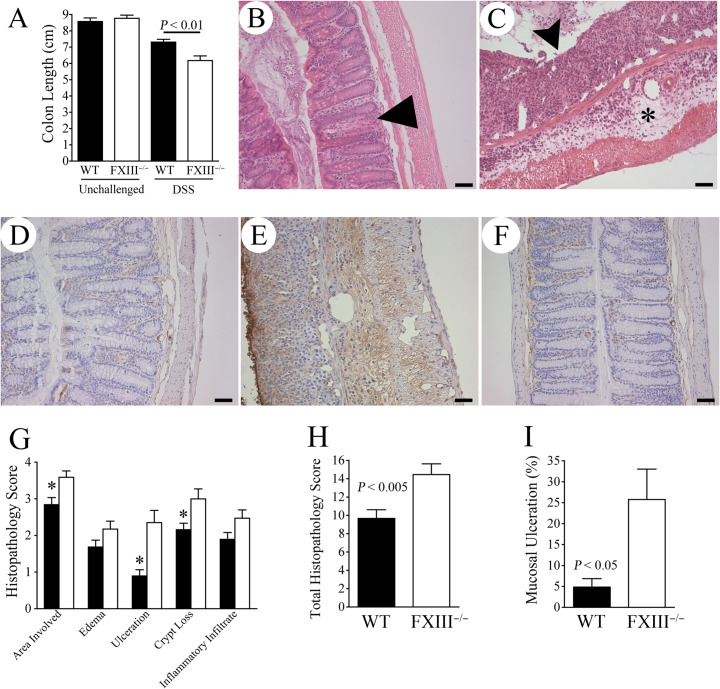
Lack of FXIII results in a failure to resolve colonic damage after DSS exposure.(A) Colon lengths observed in cohorts of WT and FXIII−/− mice 7 days after withdrawal of DSS (n = 10 per cohort). Note that colons were significantly shorter in FXIII−/− mice (consistent with more severe lingering disease) in comparison to WT mice. (B) Representative H&E-stained section of colon tissue harvested from a WT mouse 7 days after DSS withdrawal demonstrated substantial resolution of DSS-induced colitis in this time frame. Note the generally intact mucosa with mild inflammation, and occasional crypt loss and crypt spacing (triangle). (C) In contrast, colons harvested from FXIII−/− mice typically had large areas of ulceration (arrowheads) and inflammatory submucosal edema (*). (D-E) Representative immunohistochemical analyses of fibrin(ogen) deposition (detected by brown staining) within colon tissue sections harvest from WT (D) and FXIII−/− mice (E) 7 days after withdrawal of the DSS challenge. Note that interstitial fibrin(ogen) was minimal in the well-resolved colonic mucosa of WT mice; indeed, the trace fibrin(ogen) detected was generally not appreciably different from that observed in unchallenged WT mice (F). In contrast, interstitial fibrin(ogen) deposits were readily observed in the colons of FXIII−/− mice a full week after withdrawal of DSS, and were particularly intense in the numerous areas of lingering severe mucosal damage. Size bars represent 50 μm. (G-I) Colons harvested from FXIII−/− mice (white bars) had more severe microscopic features of disease relative to WT mice (black bars) in the resolution phase 7 days after withdrawal of DSS challenge based on comparative analyses of histopathology scores evaluating key individual (G) and combined (H) disease scores (n = 10 per cohort). (I) Shown are results of direct microscopic measurement of mucosal ulceration as a percentage of colon length (n = 10 per cohort). * P < 0.01, all P values were generated with a Mann-Whitney U test.